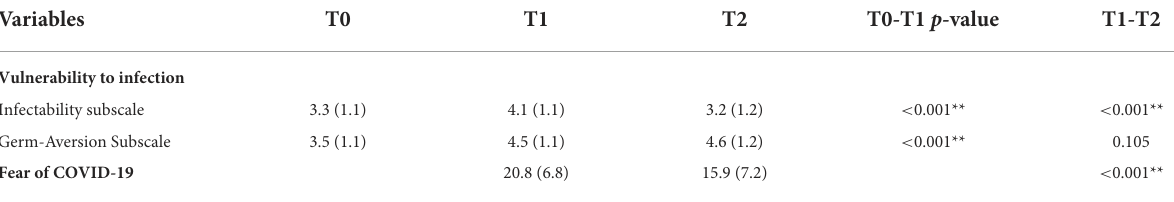
TABLE 2 Mean, standard deviation, N (%) in T0–T1, T1–T2, and significance in T0–T1, T1–T2 for the variables of perceived vulnerability to infection (Infectability subscale and Germ-Aversion Subscale) and fear of COVID-19. Variables